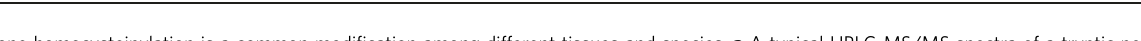
Fig. 1 Histone homocysteinylation is a common modi fi cation among different tissues and species. a A typical HPLC-MS/MS spectra of a tryptic peptide ‘ RGGVK ’ harboring H4K44 homocystylation, derived from human brain. The x and y axes represent m / z and relative ion intensity, Hcy RISGLIYEETR respectively. A series of b- and y-type homocysteinylation fragment ions are evident which not only provide reliable sequence information, but also indicate an unambiguous + 174.04600 Da shift for Hcy. b Schematic illustration of homocysteinylation sites of histone lysine residues in human normal brain samples identi fi ed using HPLC-MS/MS. The red diamond shape depicts homocysteinylation sites in core histones (H3, H4, H2a, and H2b). The number underneath each red lysine residue (K) represents the position of the particular lysine residue within each respective histone. c Veri fi cation of anti-KHcy antibody. The homocysteinylation levels of BSA (Bovine Serum Album) and KHcy modi fi ed BSA were detected with anti-KHcy antibody under the presence of 0, 2, or 5 µ g/ml of Hcy modi fi ed lysine (KHcy as competitor). CBB Coomassie Brilliant Blue staining. These test repeated for 3 times and the quantitation of the western blotting showed on right. In the BSA group, the relative K-Hcy levels were 1 ± 0.05, 1.15 ± 0.10; 1.11 ± 0.78. In the BSA-Hcy group, the relative K-Hcy levels were 10.88 ± 1.02, 5.48 ± 0.34; 1.39 ± 0.21. d Veri fi cation of speci fi city of the anti-K-Hcy antibody. Western blotting assay was carried out by incubating the anti-KHcy antibody with unmodi fi ed OVA (ovalbumin), acetylated-OVA, succinylated-OVA, or K-Hcy-OVA. e Western blotting analysis for the detection of H3 homocystylations in samples from a variety of human fetal tissues, including brain, spinal cord, heart, liver, lung, kidney, muscle, and skin. Anti-Hcy: rabbit polyclonal anti-Hcy antibody; Anti-H3: rabbit polyclonal anti-H3 antibody. f Presence of H3 homocysteinylation in different species, including D. melanogaster , Zebra fi sh, Gallus gallus brain, mouse brain, and human fetal brain, demonstrated using western blotting with rabbit